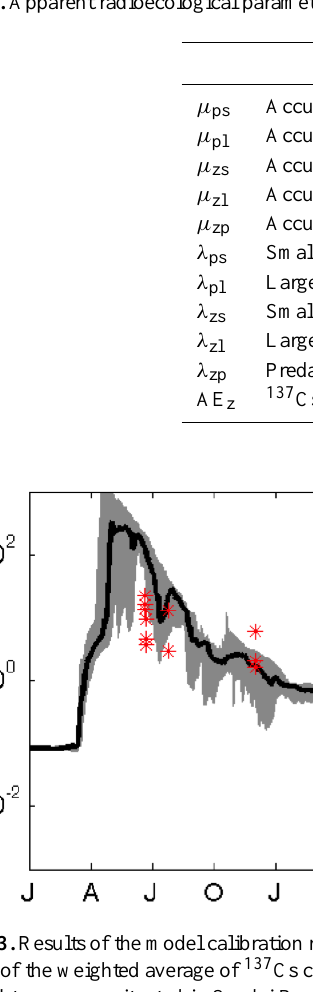
Table 2. Apparent radioecological parameters obtained from the model calibration.